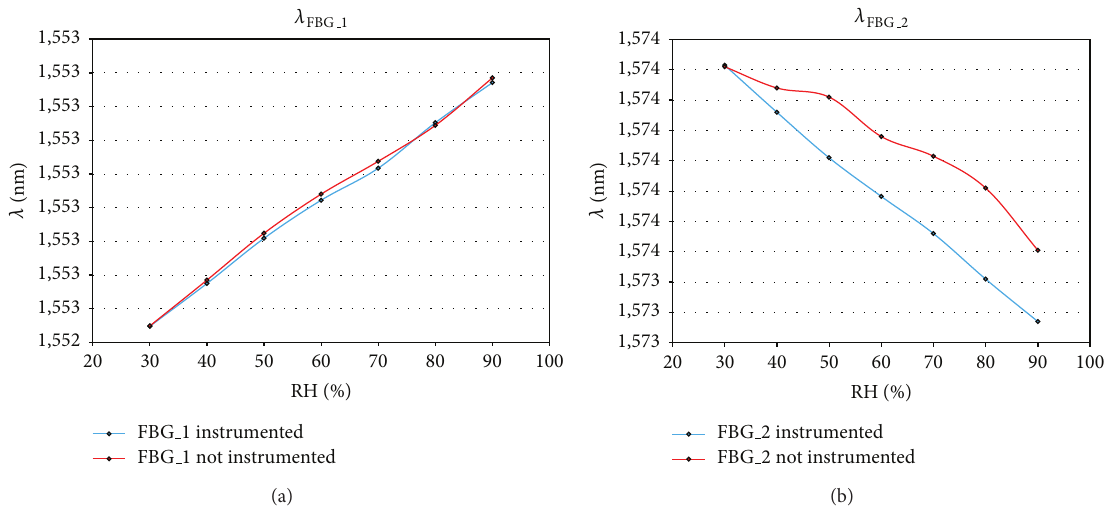
Figure 10: Wavelength shift with RH for instrumented and not instrumented sensors (a) FBG 1 and (b) FBG 2.